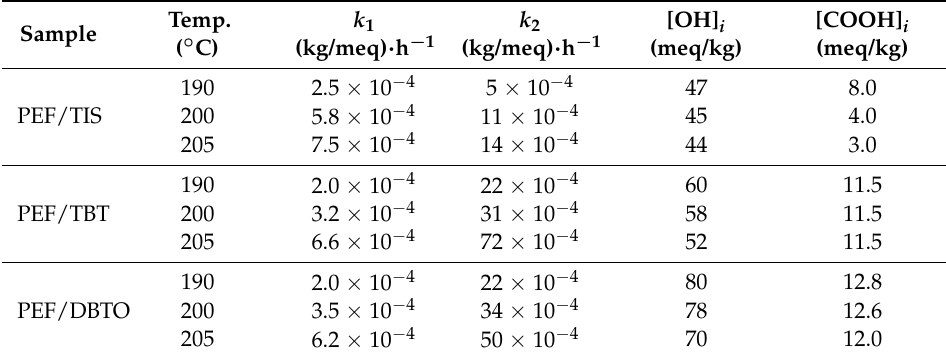
Table 2. Kinetic rate constants of the transesterification and esterification reaction and concentration of temporarily inactivated OH and COOH end-groups at different polycondensation temperatures of PEF prepared by different catalysts, TIS, TBT, and DBTO.